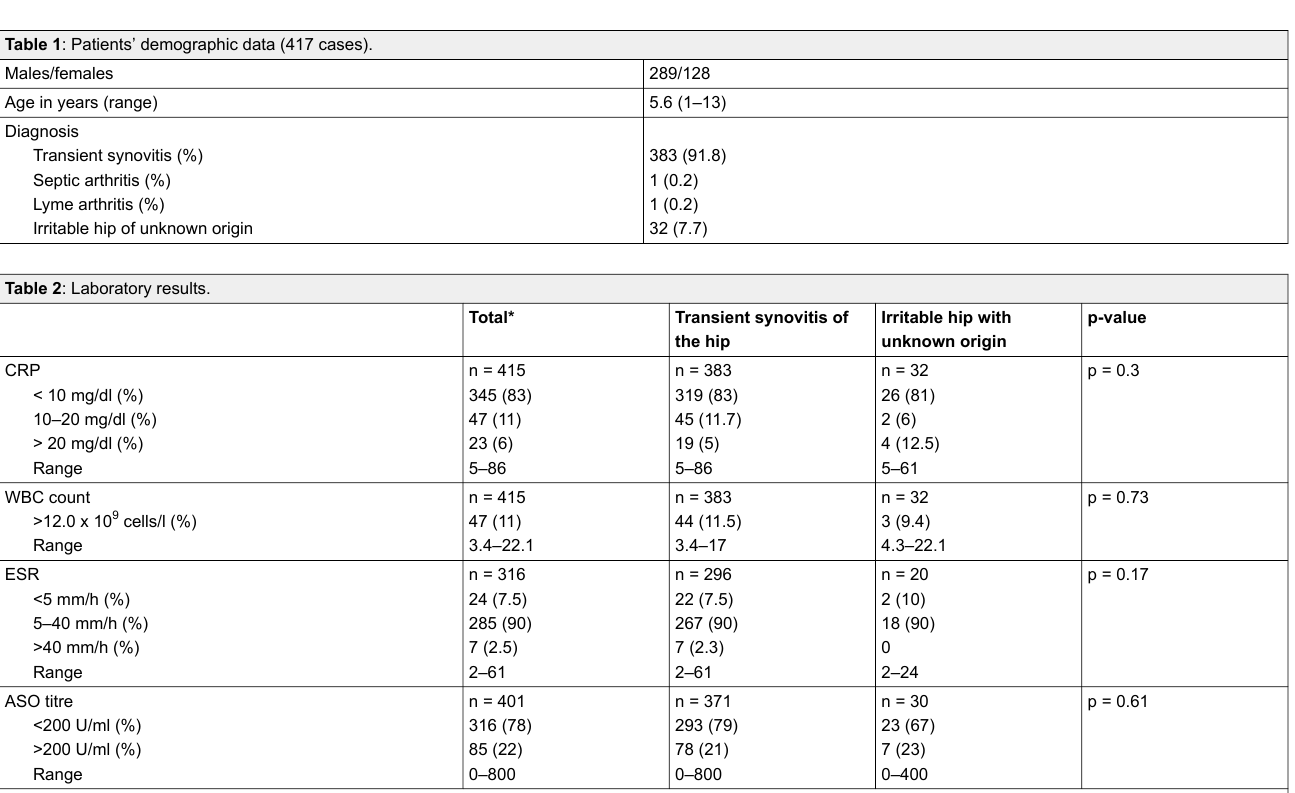
Table 1 : Patients’ demographic data (417 cases).